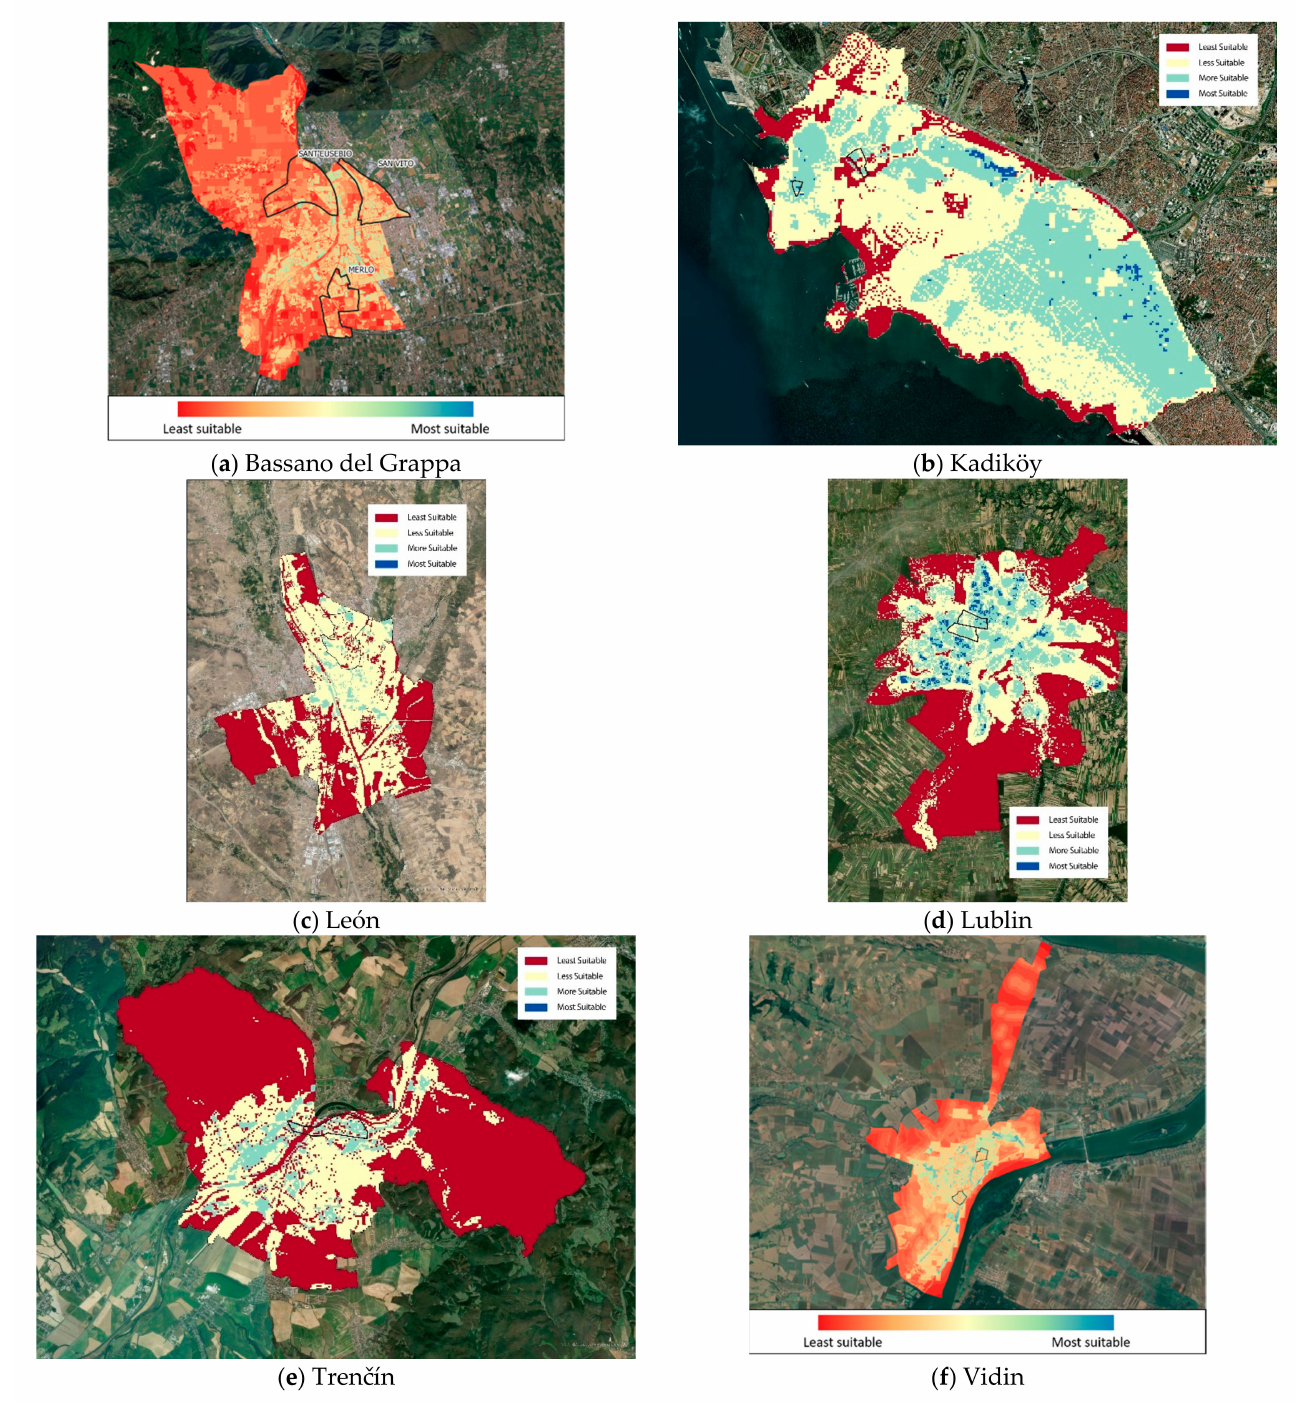
Figure 3. Weighted overlay result for cities displaying suitable areas for PED implementations. ( a ) Bassano del Grappa most to least suitable areas; ( b ) Kadikoy most to least suitable areas; ( c ) Le ó n most to least suitable areas; ( d ) Lublin most to least suitable areas; ( e ) Trenˇc í n most to least suitable areas; ( f ) Vidin most to least suitable